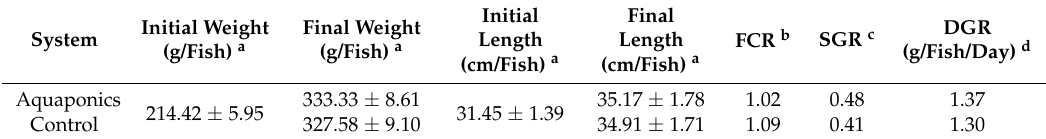
Table 3. Performance (±SEM) of the African catfish in the experimental culture systems.